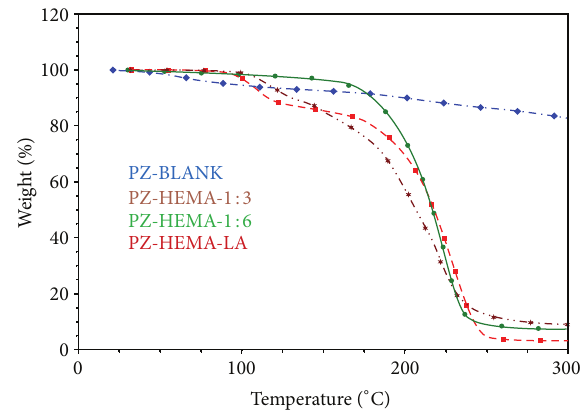
Figure 5: TGA thermograms of PZ BLANK, PZ-HEMA-1:3, PZ- HEMA-1:6, and PZ-HEMA-LA.